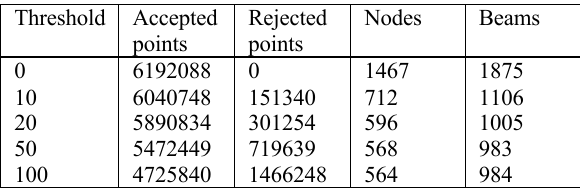
Figure 9. Examples of the extracted graphs. Left: res. 10 cm, threshold 20. Right: res. 20 cm, threshold 50.